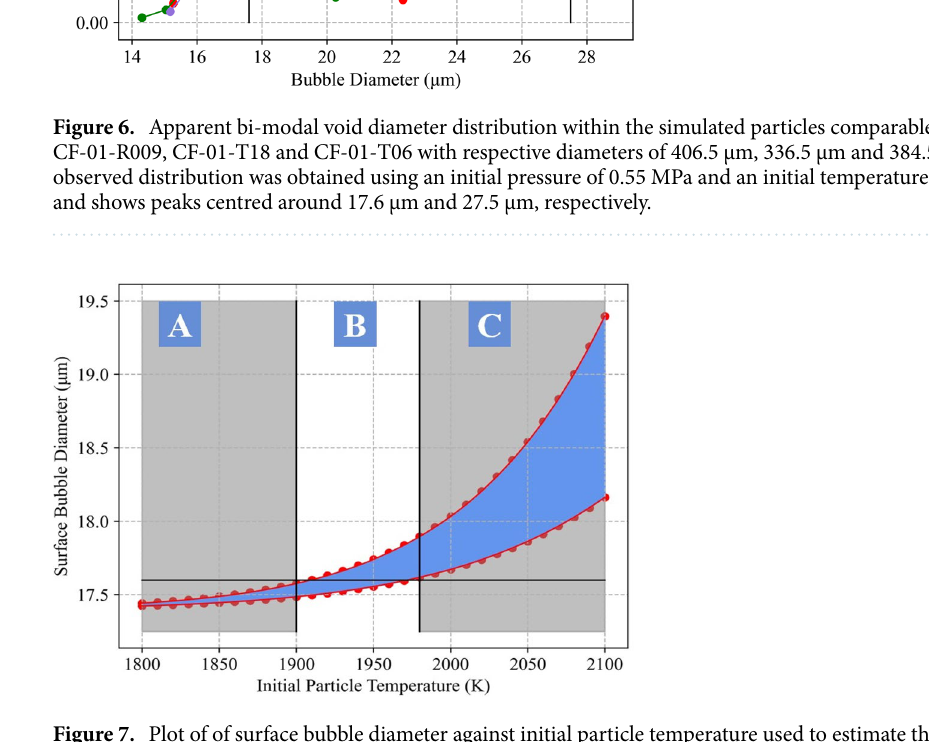
Figure 7. Plot of of surface bubble diameter against initial particle temperature used to estimate the temperature within reactor Unit 1. Region A marks the temperatures which were deemed too low, due to negligible central void growth, whereas region C marks those deemed too high, due to excess growth of surface level voids. Region B, however, marks the obtained estimated temperature range. The observed spread is due to the range of bubble diameters produced across the range of calibration